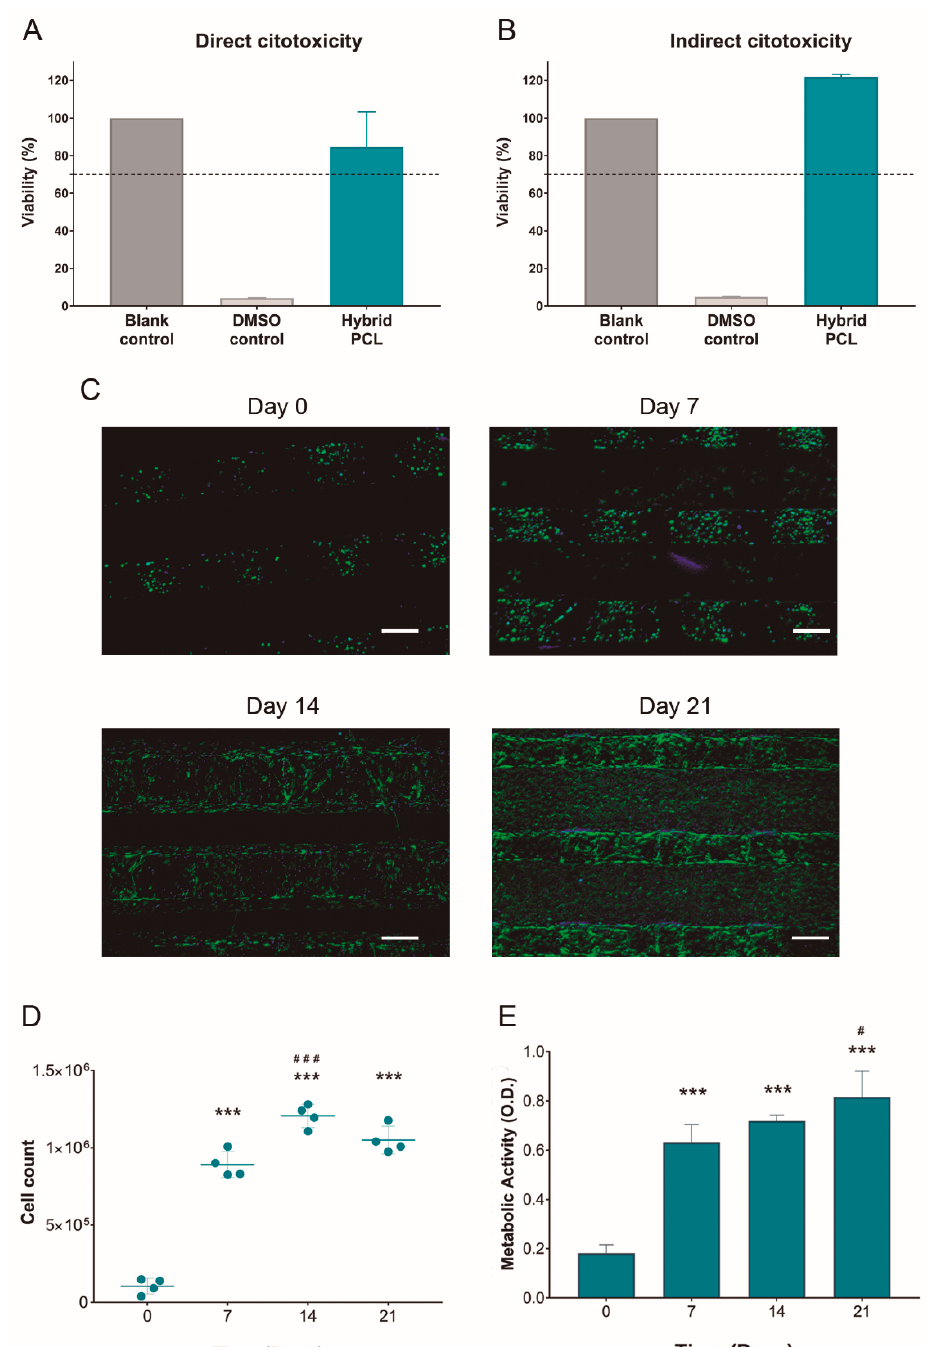
Figure 3. Cell culture on hybrid PCL scaffolds. ( A ) Direct and ( B ) indirect cytotoxicity studies performed with L-929 fibroblasts following ISO 10993-5:2009 guidelines. ( C – E ) MC-3T3 murine osteoblast culture on hybrid PCL scaffolds: ( C ) fluorescent DAPI/Phalloidin micrographs for cell distribution and morphology, ( D ) proliferation and ( E ) metabolic activity of MC-3T3 at different time points. Results are shown as the mean ± standard deviation ( n = 4). Scale bars = 200 µ m. Statistical significance: *** p < 0.001 compared to day 0. # p < 0.05 and ### p < 0.001 compared to day